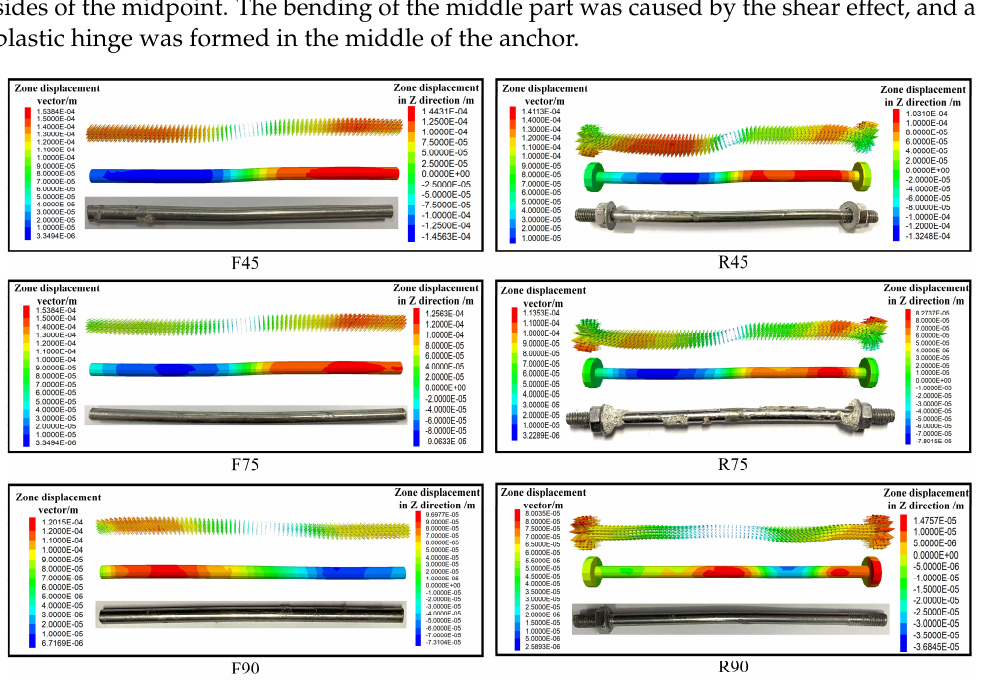
Figure 24. Comparison of experimental and numerical anchor deformation.